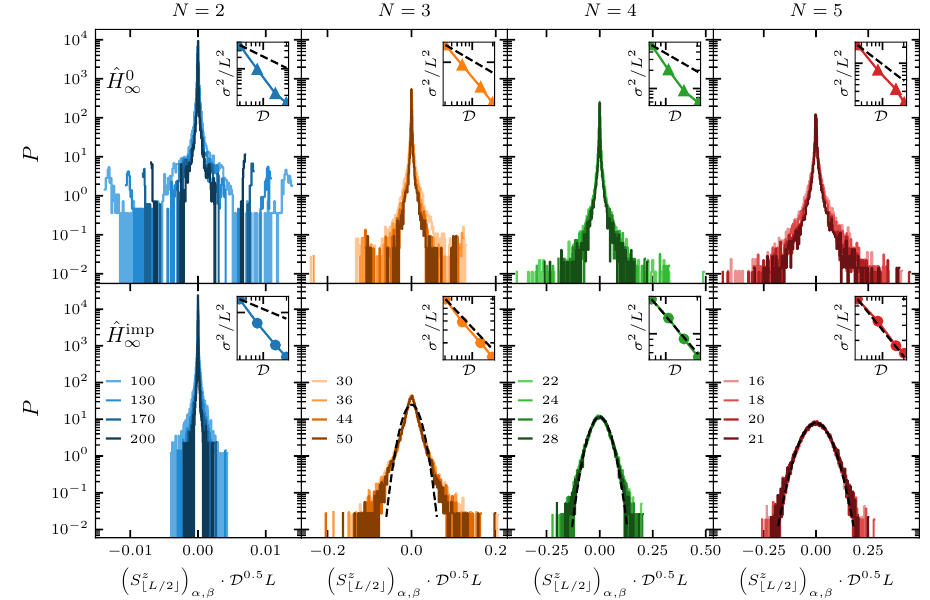
Figure 2: Distribution of the off-diagonal elements of ˆ S z , computed for 200 eigen- (cid:98) L / 2 (cid:99) states in the middle of the spectrum, for the integrable model ˆ H 0 (top row) and the ∞ single-impurity model ˆ H imp ∞ (bottom row) for different number of excitations (dif- ferent columns). In each panel, larger system sizes are represented by darker colors 0.5 L . The insets display log-log plots of (see legends). The histograms are scaled by D the scaled variance σ 2 / L 2 against the Hilbert space dimension and the black dashed − 1 lines correspond to σ 2 / L 2 ∝ D